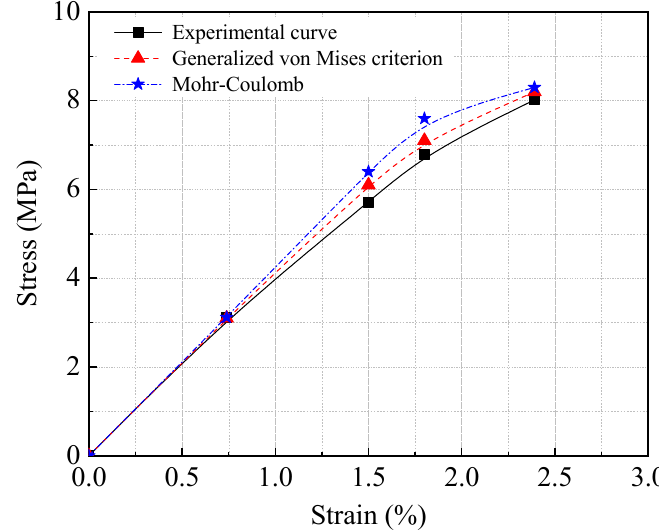
Figure 4. Comparison of the Stress–Strain Curves.